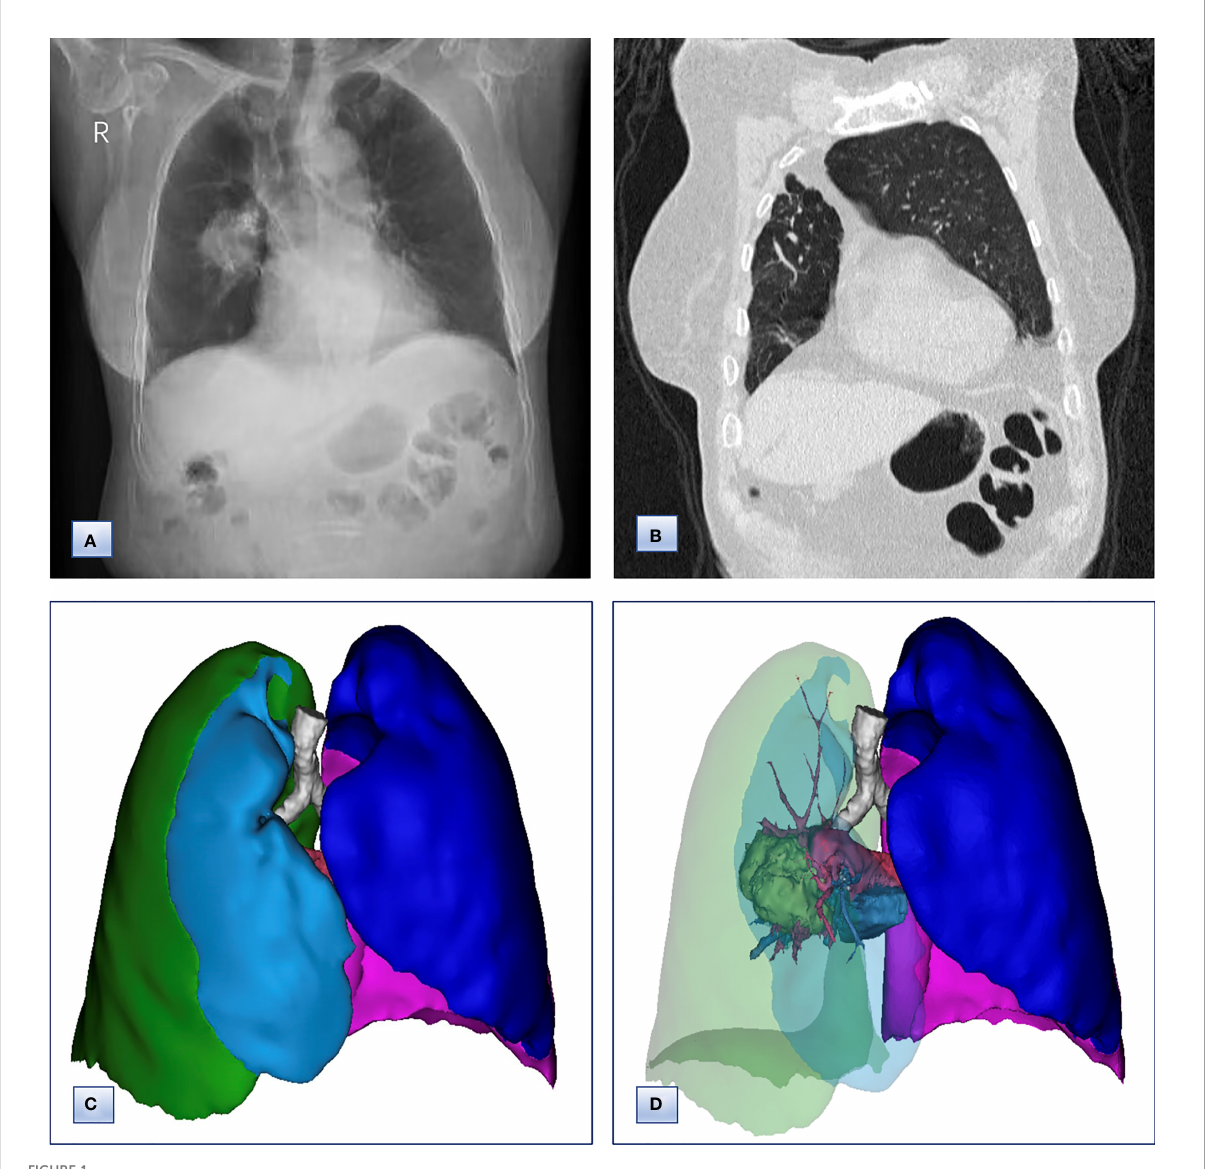
FIGURE 1 Chest radiographs, computed tomography and 3D CT reconstruction before surgery. (A) Chest radiographs, revealing that the trachea and mediastinum were shifted to the right. (B) Coronal chest CT images, indicating the absence of a horizontal fi ssure anterior to the aorta, with anterior herniation of the left lung crossing the midline. (C, D) 3D reconstruction of CT images, showing (C) only two lobes of the right lung and (D) complete absence of lung tissue from the right upper lobe, including the lung parenchyma, pulmonary vessels and bronchial